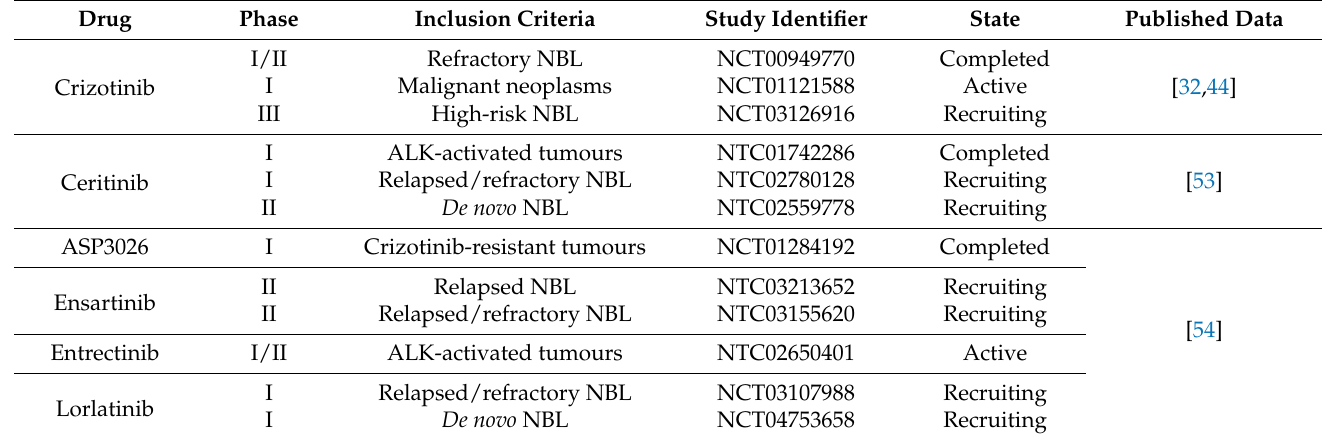
Table 3. ALK inhibitors in clinical trials that include NBL